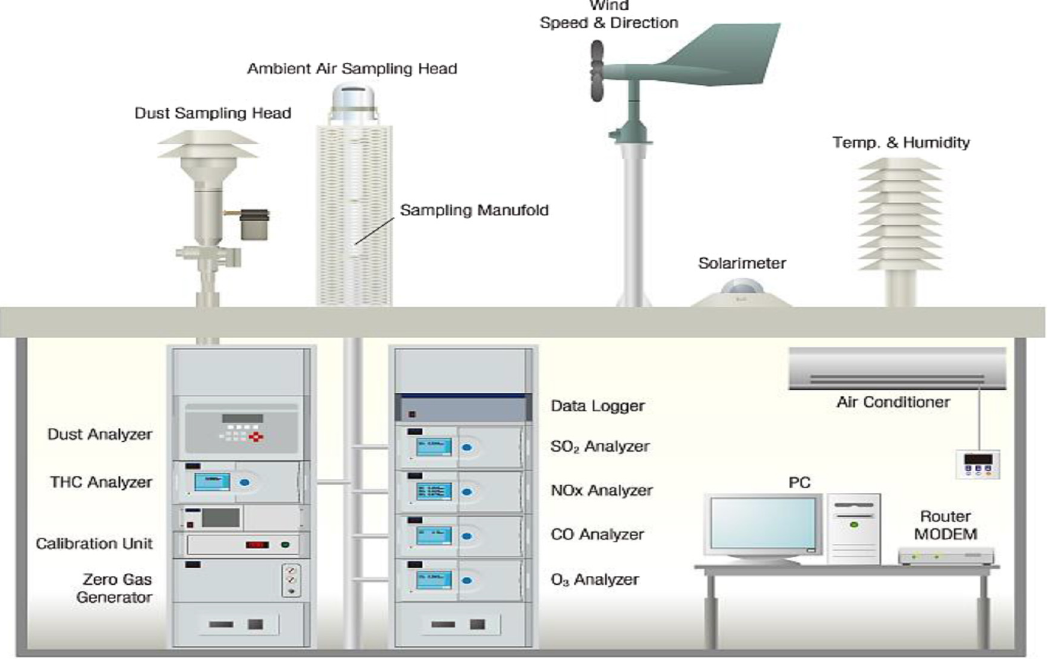
Fig. 4. Air quality station module [22].